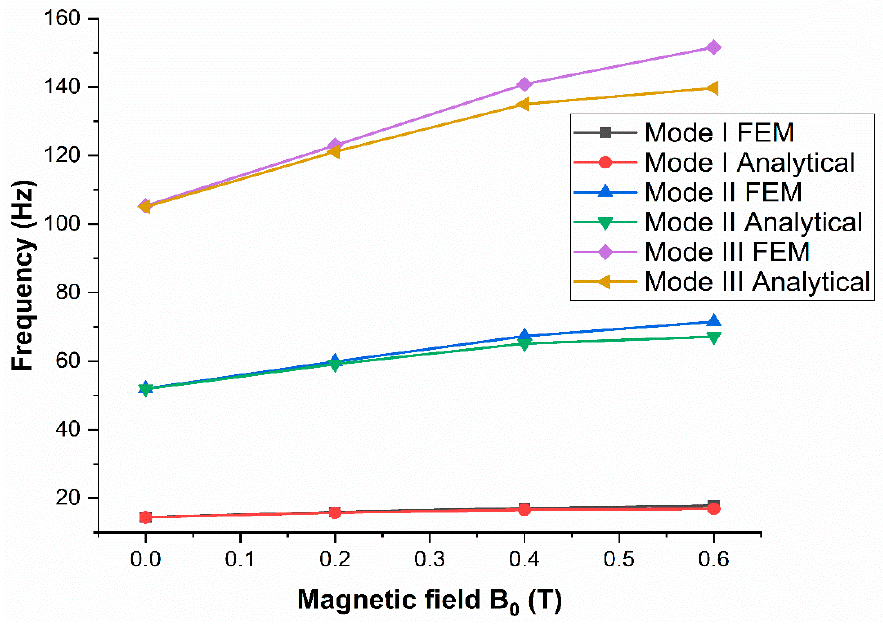
Figure 9. Experimental natural frequency at different magnetic field regions.